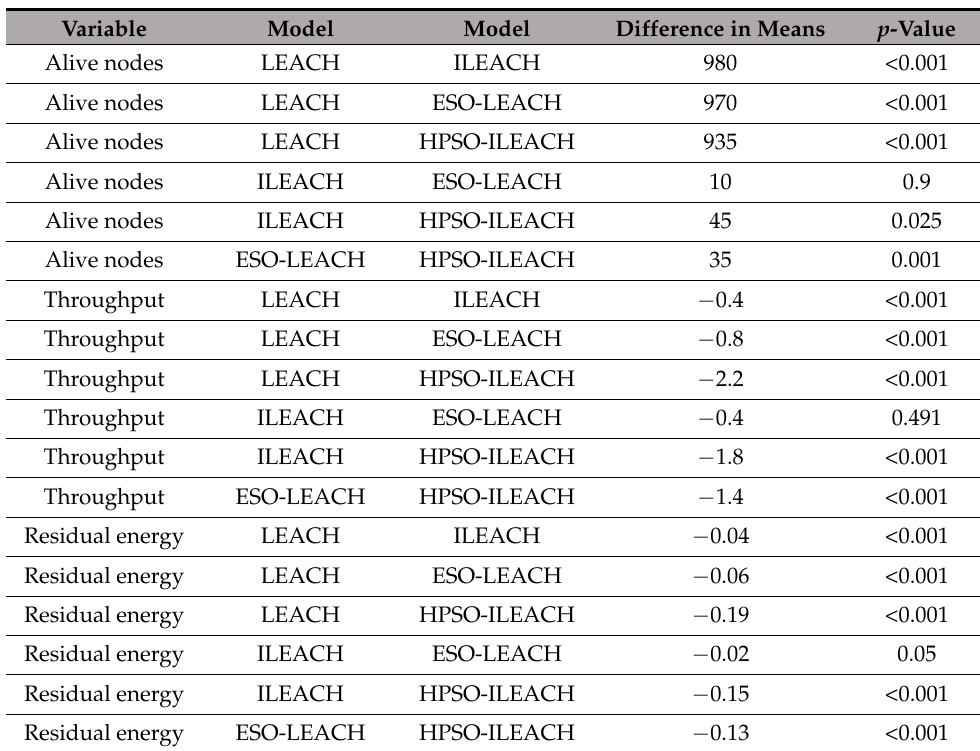
Table 7. The results of the Tukey HSD